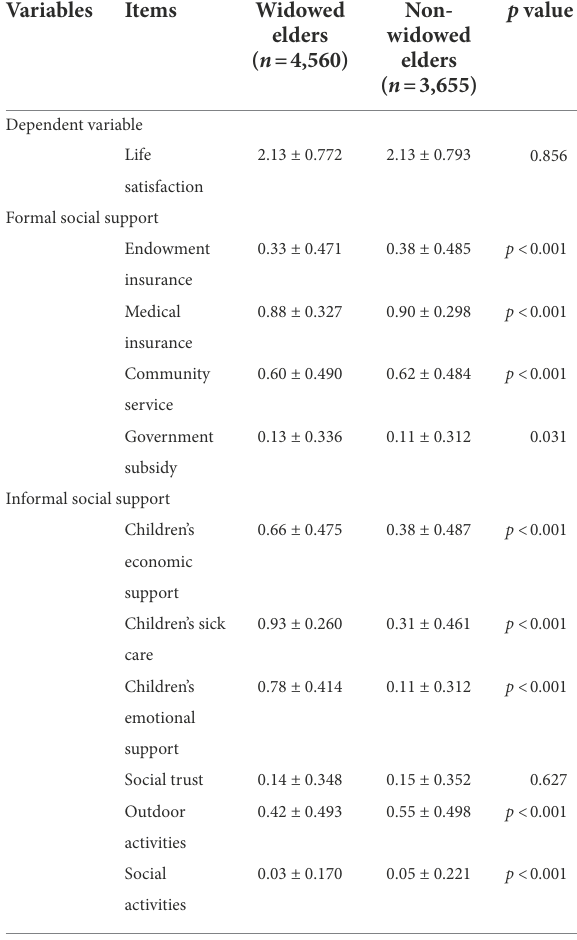
TABLE 3 Differences in social support between widowed and non- widowed elders.